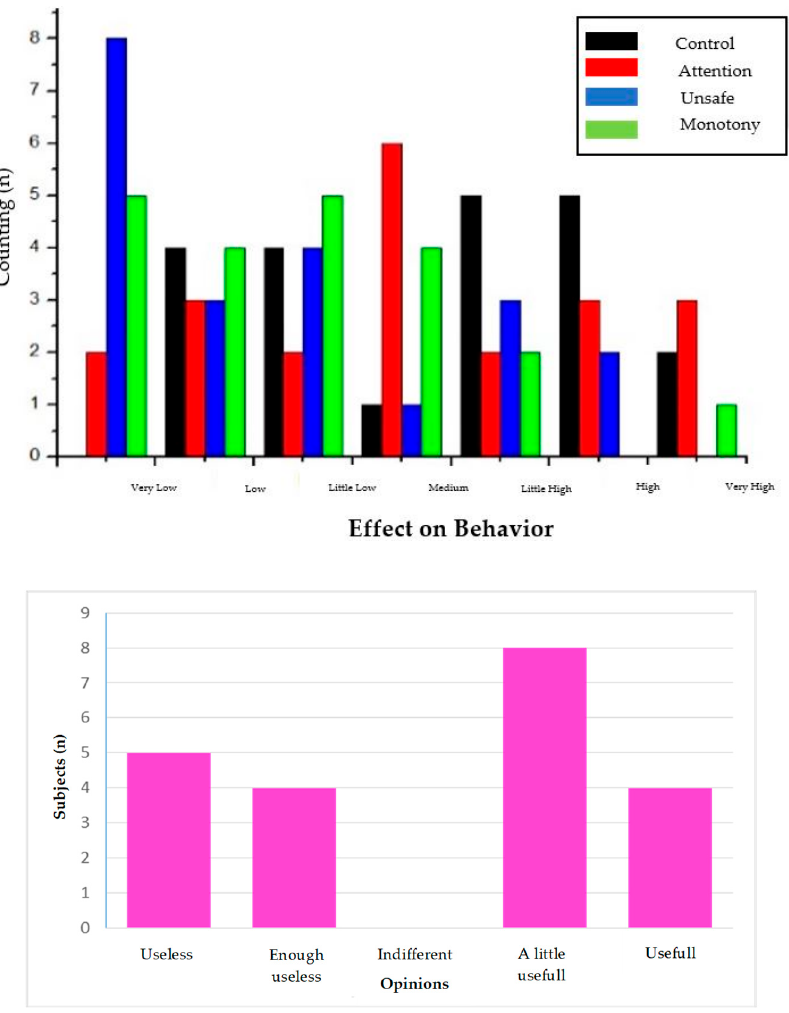
Figure 8. Analysis of the survey.